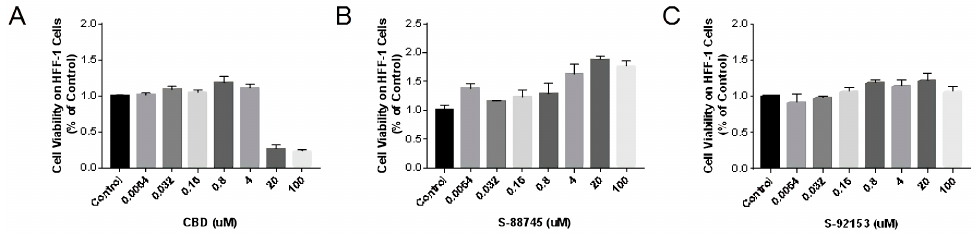
Figure 8. Cytotoxicity of ( A ) CBD and its derivatives, ( B ) S-88745 and ( C ) S-92153, on HFF-1 cells. HFF-1 cells were treated with cannabidiol, S-88745 or S-92153 for 72 h, and MTT assay was carried to detect the cell viability. The experiments were repeated three times. Each bar illustrates the average ± standard deviation (SD) counted from three experiments.